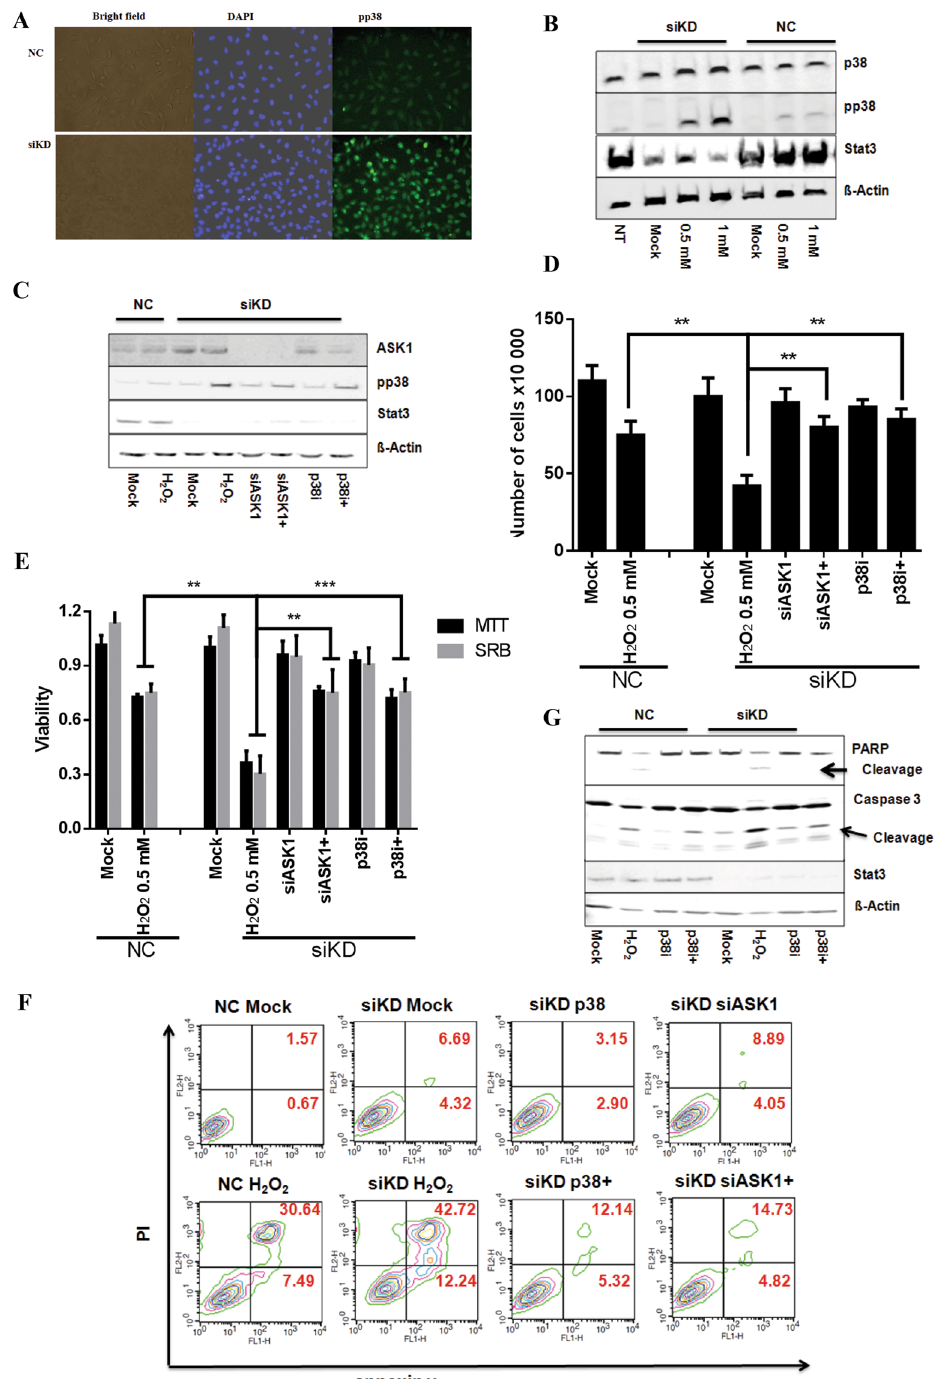
Figure 2. ASK1/p38 MAPK signaling pathway plays an important role for inducing synergistic effect in Stat3- deficient HeLa cells under oxidative stress. ( A ) p38 MAPK was activated in siKD cells in the presence of 1 mM H 2 O 2 for 1 hr. Phospho-p38 MAPK was stained with pp38 MAPK antibody as green and nuclei were visualized with DAPI as blue. ( B ) Activated p38 MAPK was detected in siKD cells treated with H 2 O 2 . Cells (wt, NC or siKD) were treated with two concentrations of H 2 O 2 for 1 hr. Whole cell lysates were subjected to immunoblotting and analyzed for phospho-p38 MAPK , total p38 MAPK and Stat3 using respective antibodies. ß-actin was used as loading control. 40 µ g proteins were loaded per lane. ( C) ASK1 siRNA (siASK1) and p38 MAPK inhibitor (p38i) reduced phosphorylation of p38 MAPK . Cells were transfected with Stat3 and ASK1 siRNA for 48 hrs. Non- targeting siRNA was used as control in NC cells. Cells were incubated with H 2 O 2 in absence or presence of p38i for 1 hr. Whole cell lysates were analyzed by immunoblotting for expression of phospho-p38 MAPK , ASK1, Stat3 and ß-Actin. ( D ) and ( E ) p38i or siASK1 increased cell survival. Cells were treated with 0.5 mM H 2 O 2 in combination with p38i or siASK1 for 24 hrs. The cell growth was measured using Trypan blue (D),